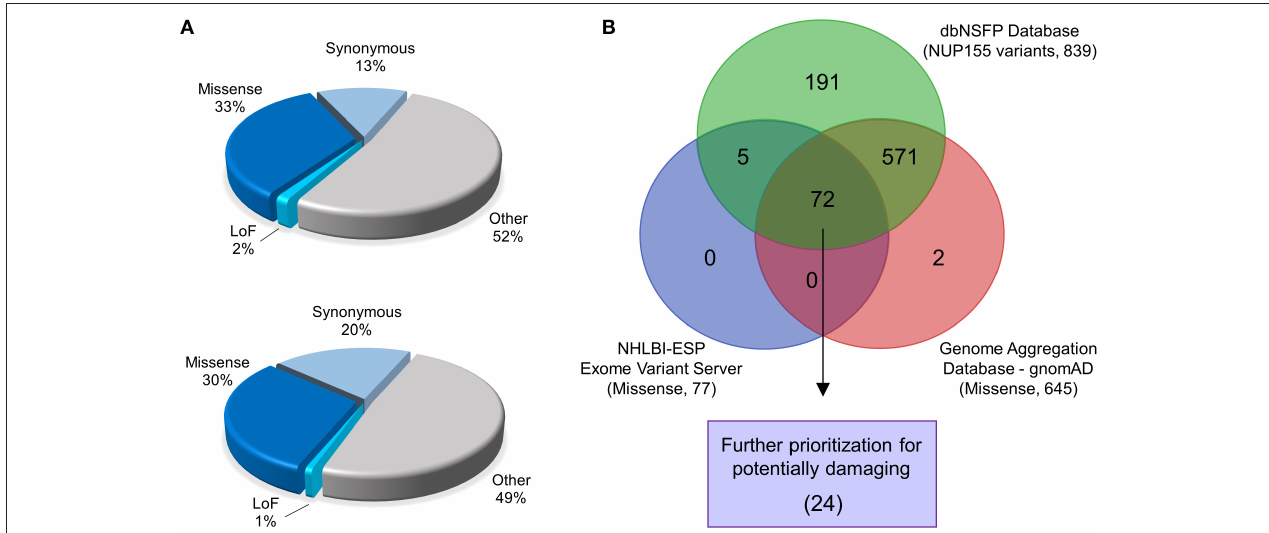
FIGURE 1 | Identification of prioritized variants of NUP155 . (A) The gnomAD (top pie chart) and NHLBI-EVS (bottom pie chart) databases were used to identify potential pathogenic nup variants in the context of cardiovascular disease cohorts. Schematic pie charts represent synonymous, missense, loss of function (LoF) and other (untranslated regions, splice region, and intronic sequences) mutations in each database, respectively. (B) Missense nup variants in the gnomAD database were compared to those in the NHLBI-EVS and the dbNSFP datasets to identify variant overlap. From a total of 72 variants determined from all three databases, 24 variants were prioritized as probably